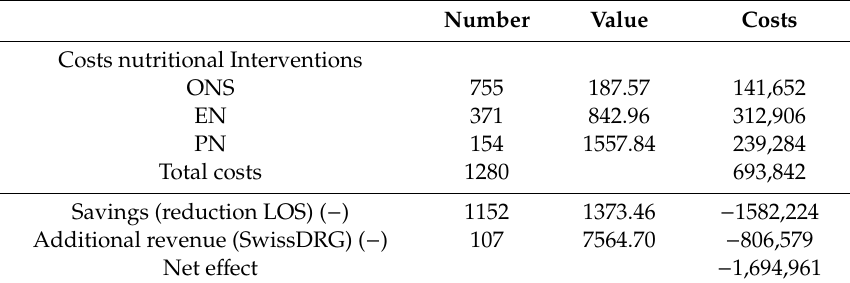
Table A2. Consequences of the costs of